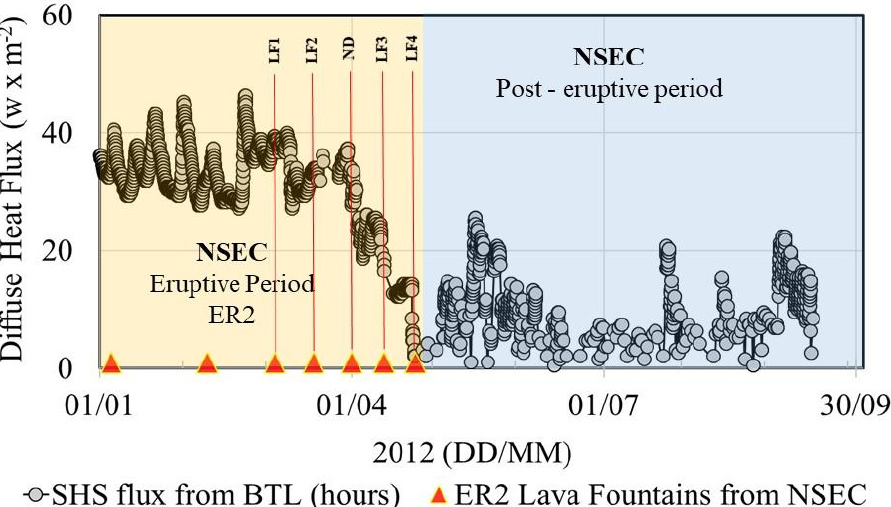
Figure 6. Focus on the hourly variations of the heat flux retrieved during 2012, showing the marked decrease early before the end of the eruptive activity. The labeled LFs are listed in Table 2.